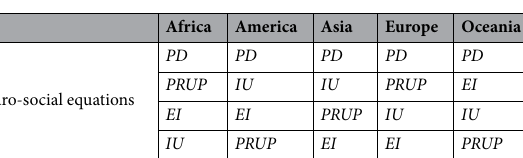
Table 8. Summary of hydro-social equations